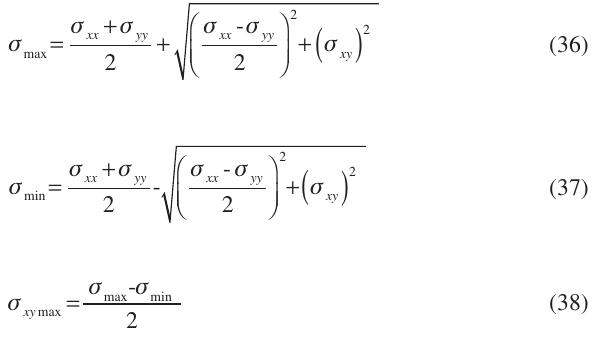
, 2 σ and maximum shear stress 2 σ for various values of the power-law exponent at fi xed end for min max 12max ( – – – – ); 2 σ ( – – – ); 2 σ ( – – – 12max min max